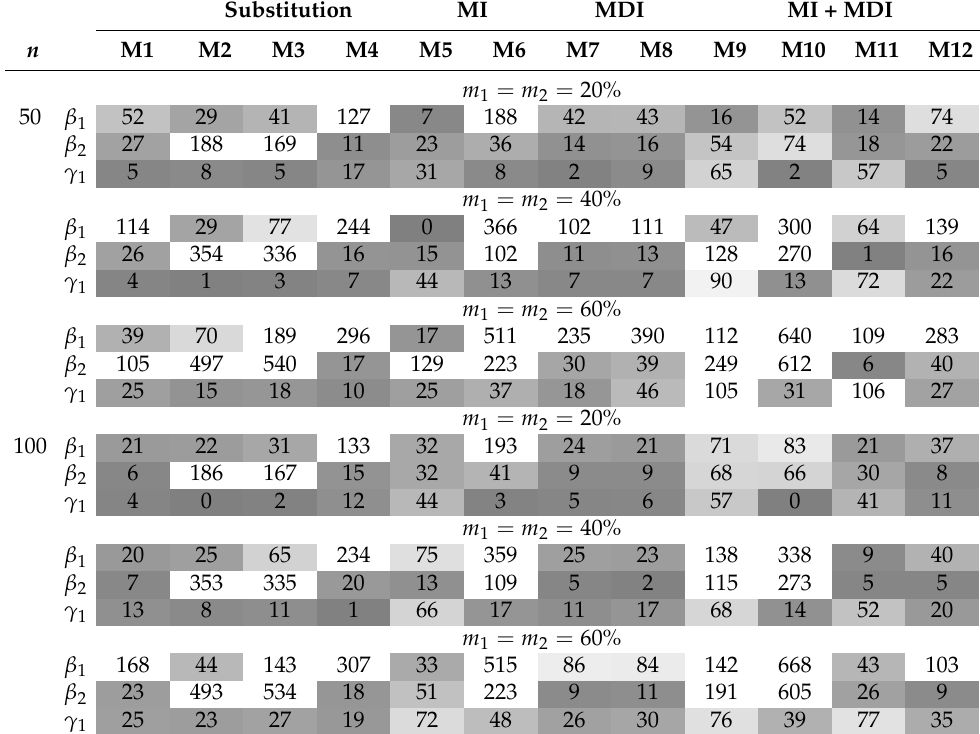
Table 3. Summary of the AAB ( × 1000) when covariates are correlated and X ∗ to lower LOD. M1 is complete case analysis; M2–M4 are the different variants of the substitution methods; M5–M6 are the different variants of the MI methods; M7–M8 are the different variants of the MDI methods; M9–M12 are the different variants of MDI-embedded MI (MI + MDI) methods. AAB less than 0.1 is highlighted in gray, with darker tones corresponding to smaller